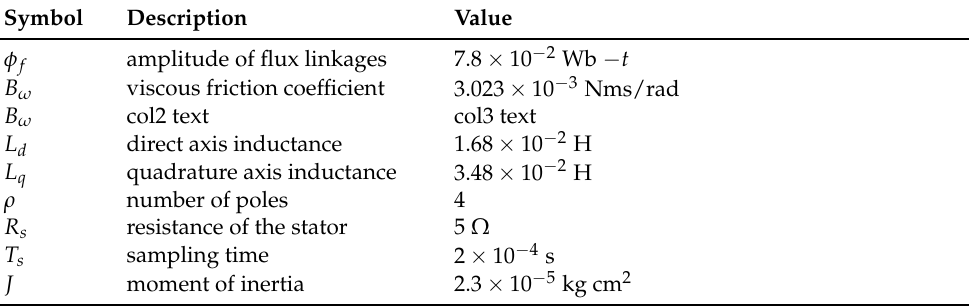
Table 3. Parameters Selected for PMSM